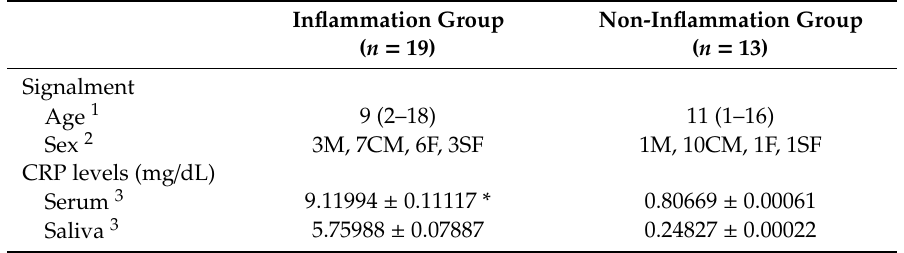
Table 2. Comparison of the signalment and median CRP levels of the inflammation group and non-inflammation